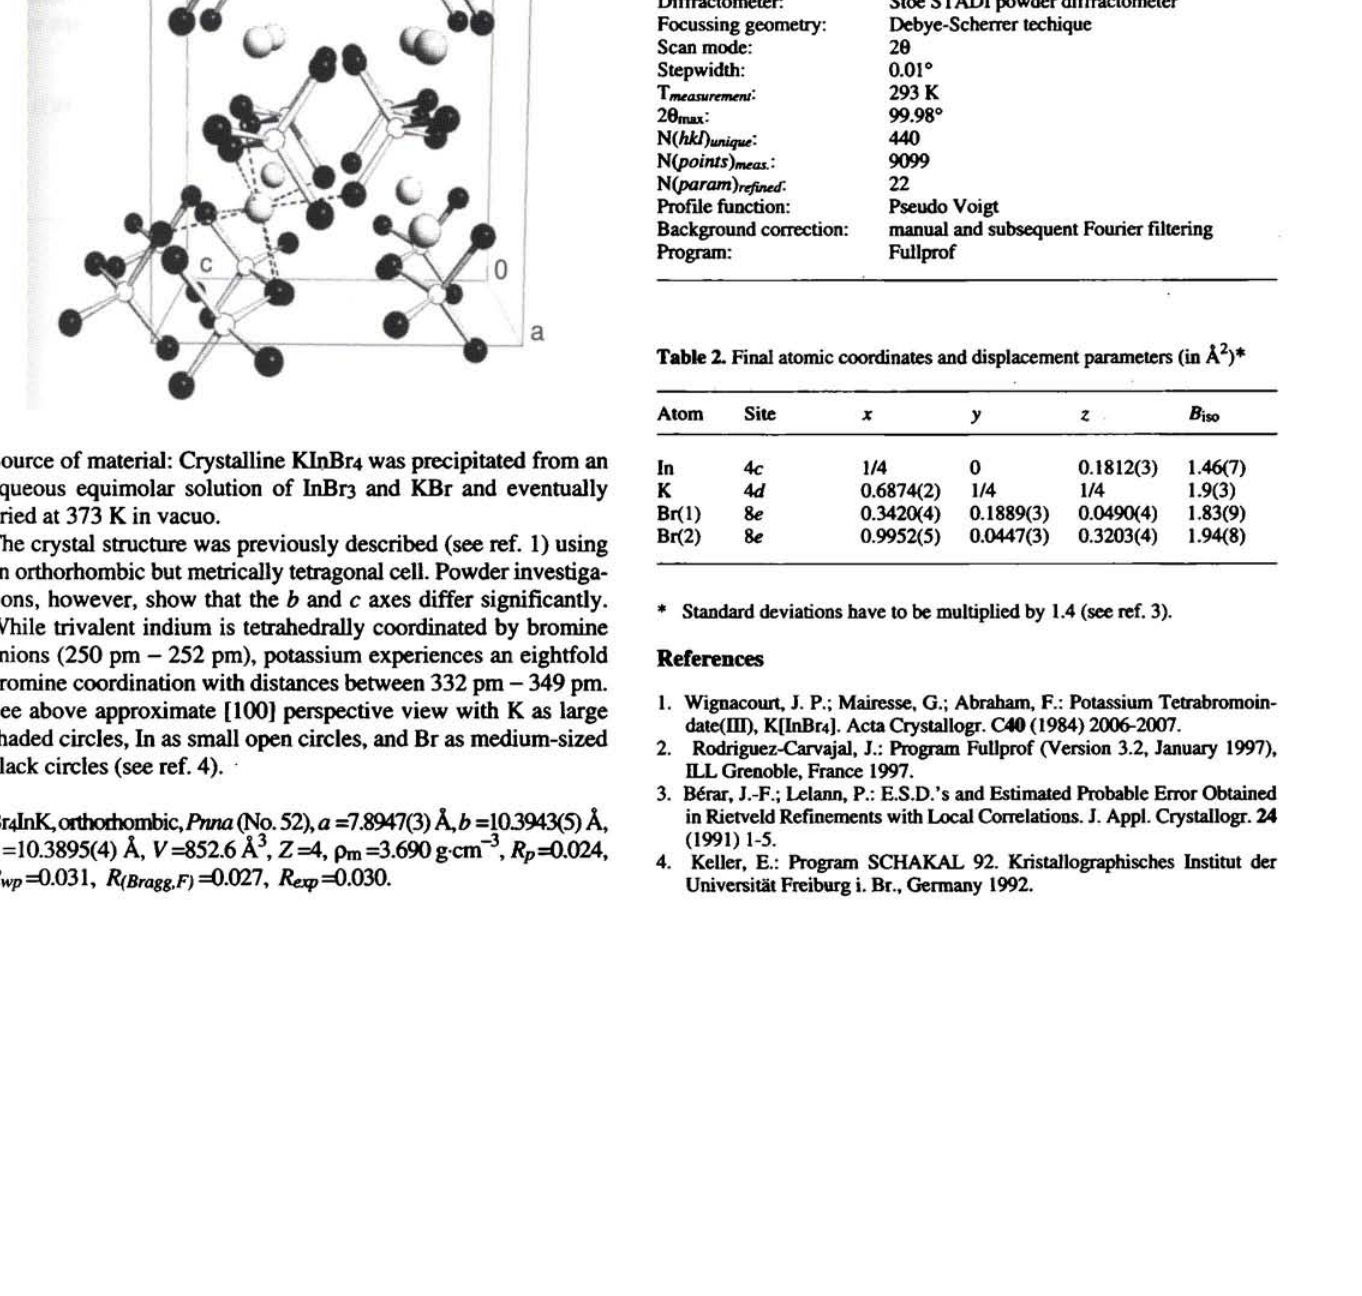
Stoe STADI powder diffiractometer